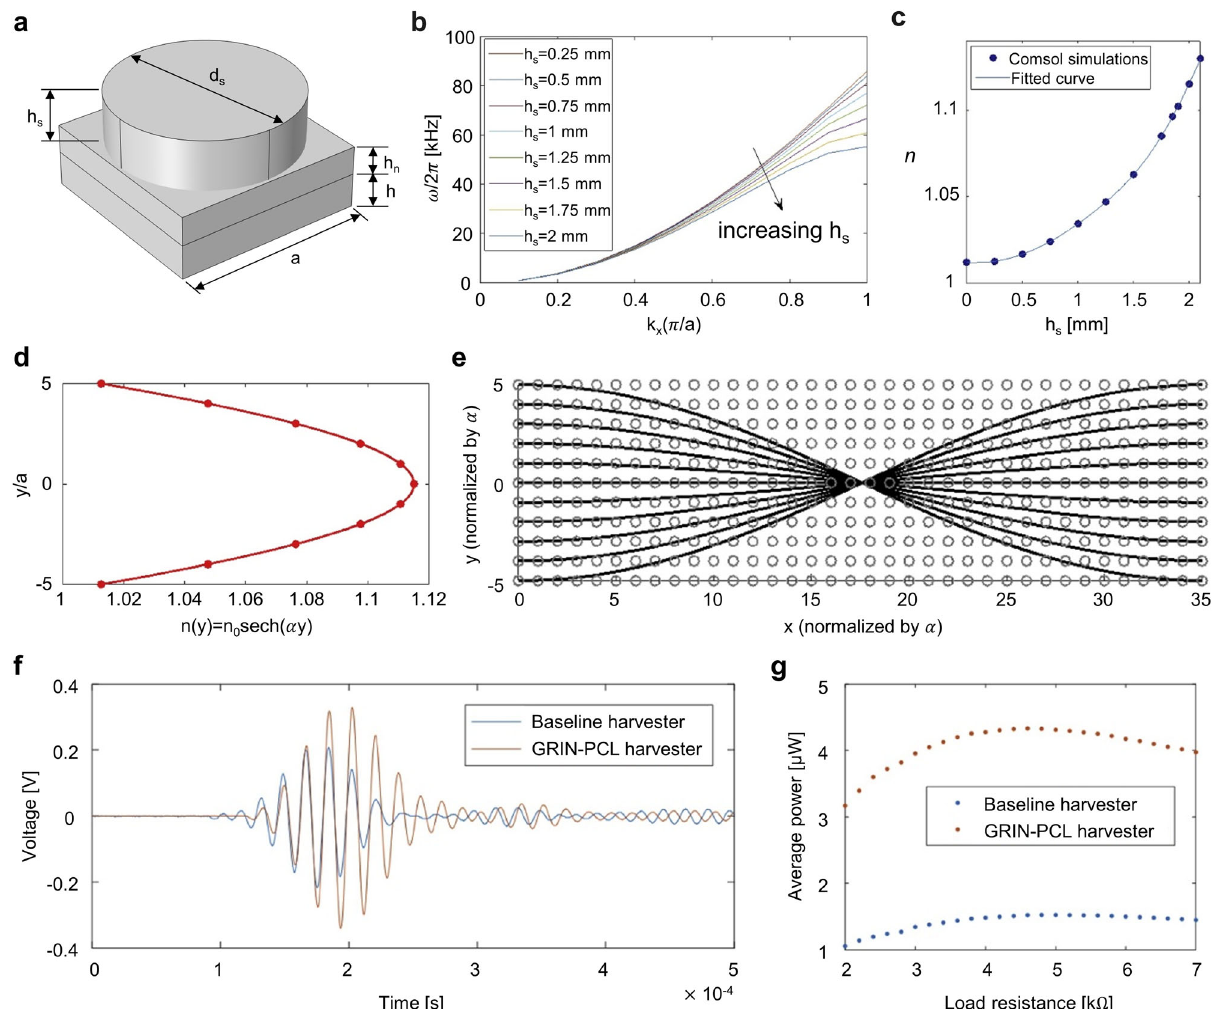
Fig. 8 3D-printed gradient-index (GRIN) lens for elastic wave focusing and energy harvesting. a Unit cell composed of heterogeneous materials. b Band structure of the lowest extensional Lamb wave along the x -direction with varying stub heights. c Refractive index of the unit cell as it varies with stub height. d Hyperbolic secant distribution of the refractive-index pro fi le and e beam trajectory obtained from the same pro fi le analytically. f , g Energy harvesting: Output voltage per time and average power per load resistance with and without a GRIN-phononic crystal lens (GRIN-PCL) 91 . Reprinted with permission from ref. 91